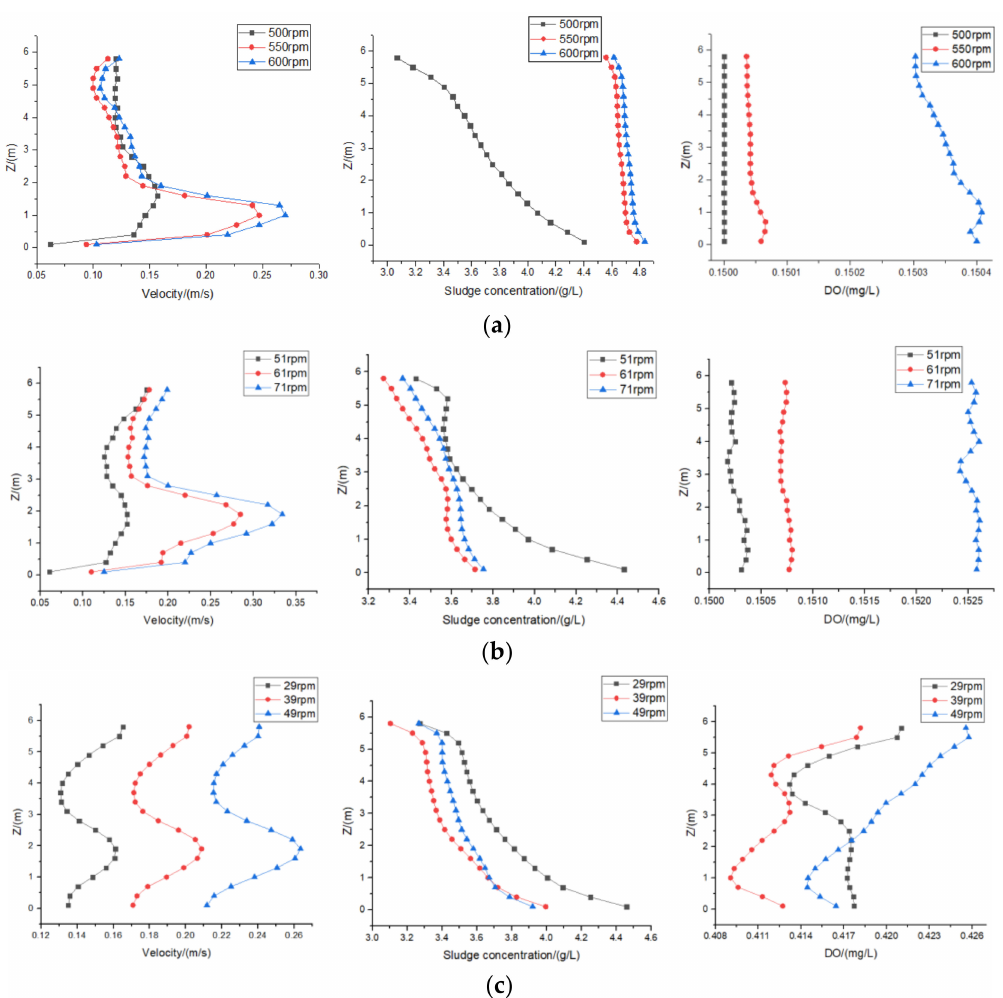
Figure 15. Curves of average velocity, sludge concentration, and DO concentration at each section. ( a ) Biological selection pool; ( b ) Anaerobic pool; ( c ) Anoxic